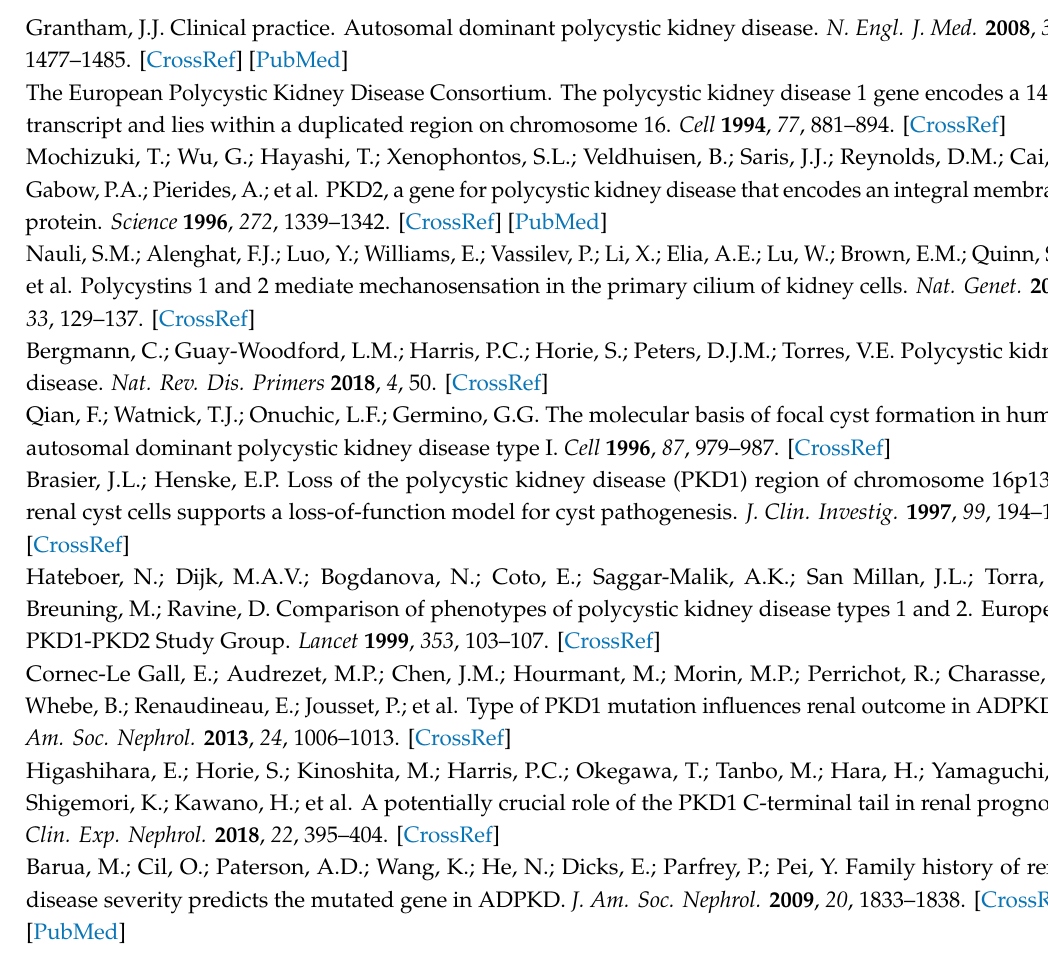
Figure S1: Patient selection flowchart, Table S1: Mutations in PKD1 and PKD2 detected in eight ADPKD patients, Table S2: Patient characteristics stratified by sex, Table S3: Patients reaching RRT with mutations in PKD1 and PKD2, Data S1: The datasets analyzed for the present